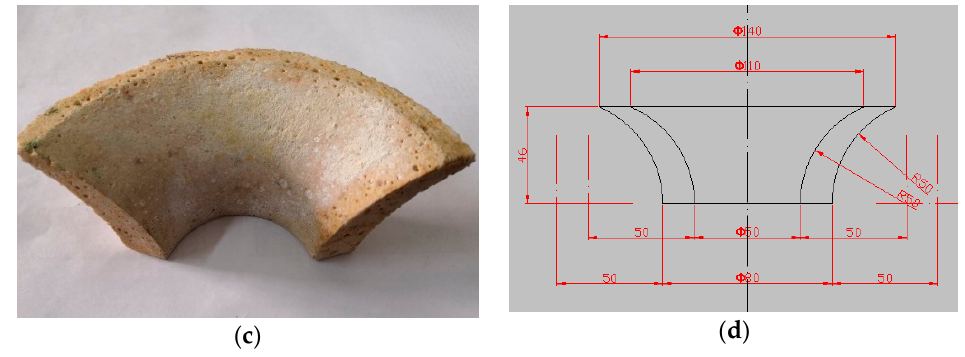
Figure 2. Tundish nozzle in the water model and the permeable brick component: ( a ) tundish nozzle in the water model; ( b ) observation zone; ( c ) permeable brick component; ( d ) section size of the permeable brick component.